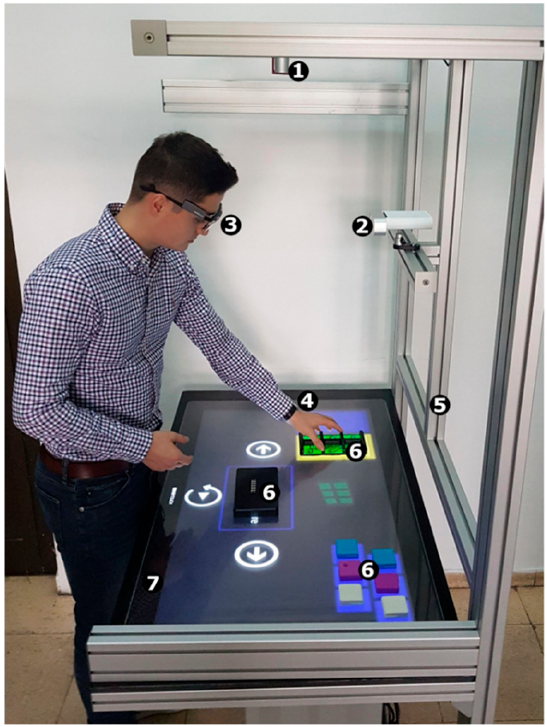
Figure 1. Manual assembly assistance system. 1: Depth camera for object detection; 2: facial expression and posture recognition sensor; 3: eye-tracking glasses; 4: GSR sensor; 5: height adjustable frame; 6: different parts of the assembled object; 7: large touchscreen.